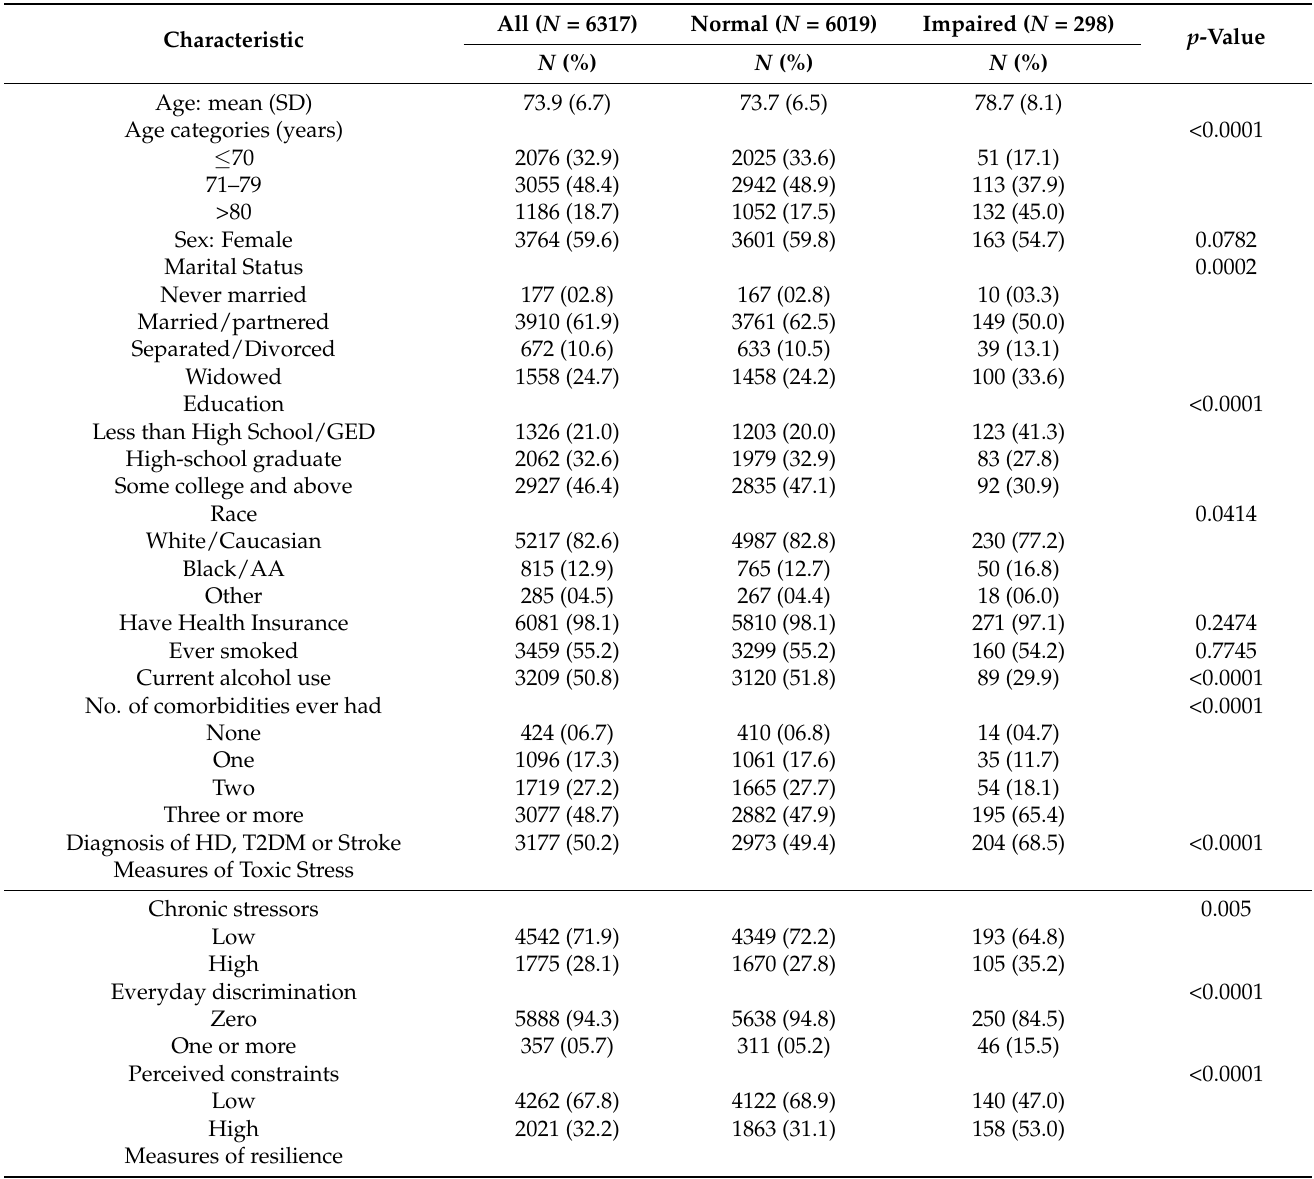
Table 1. Demographic characteristics of older American adults enrolled in the Health and Retirement Study (HRS) 2012–2014 sample by cognitive function